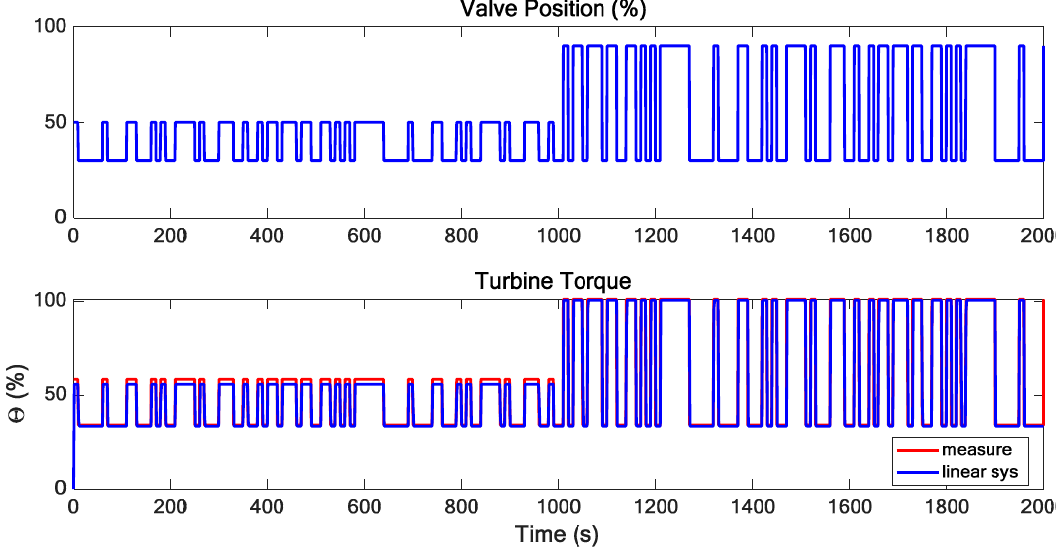
Figure 6. Model identification results.